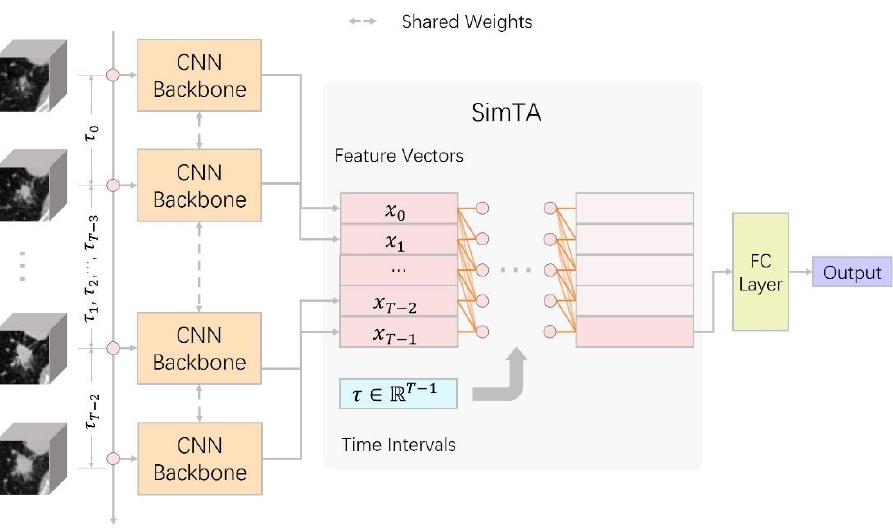
Figure 1. The model overview of the proposed ViSTA. It consists of a CNN backbone followed by the SimTA module made up of several SimTA